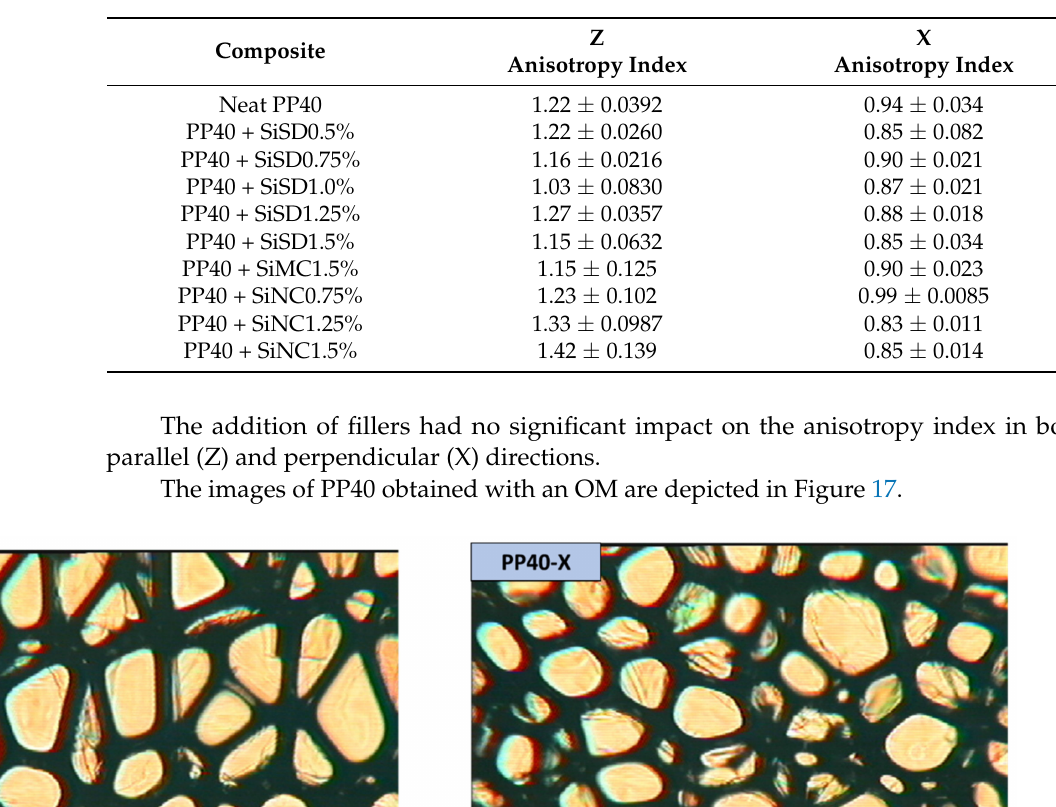
Table 4. Anisotropy index of neat PP40 and PP40 composites.